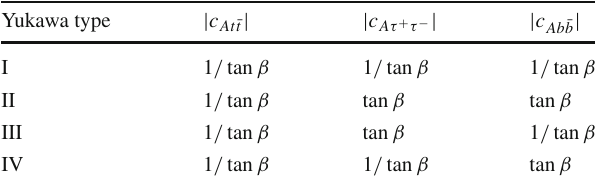
Table 5 Effective coupling coefficients of the CP-odd Higgs boson A to top quarks, bottom quarks and τ